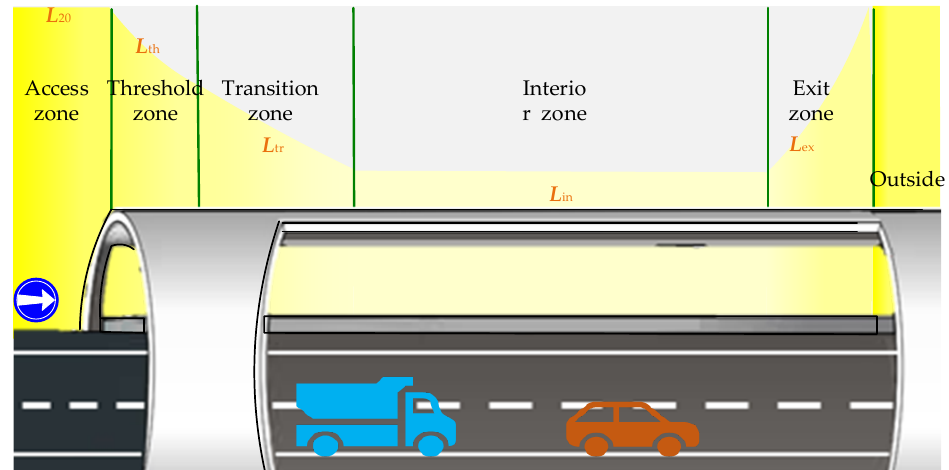
Figure 5. Lighting zones of a road tunnel.